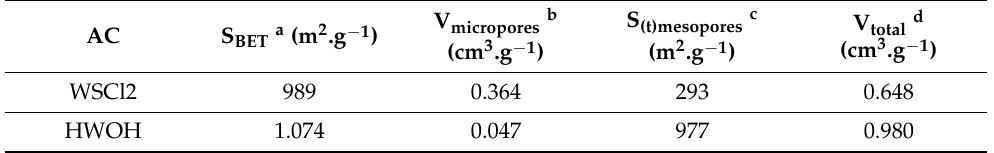
Table 1. Main textural properties of AC